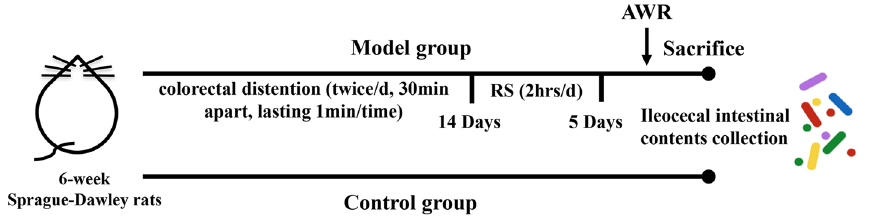
Figure 1. Design of the IBS model using male Sprague-Dawley rats (control group: n = 10; IBS group: n =